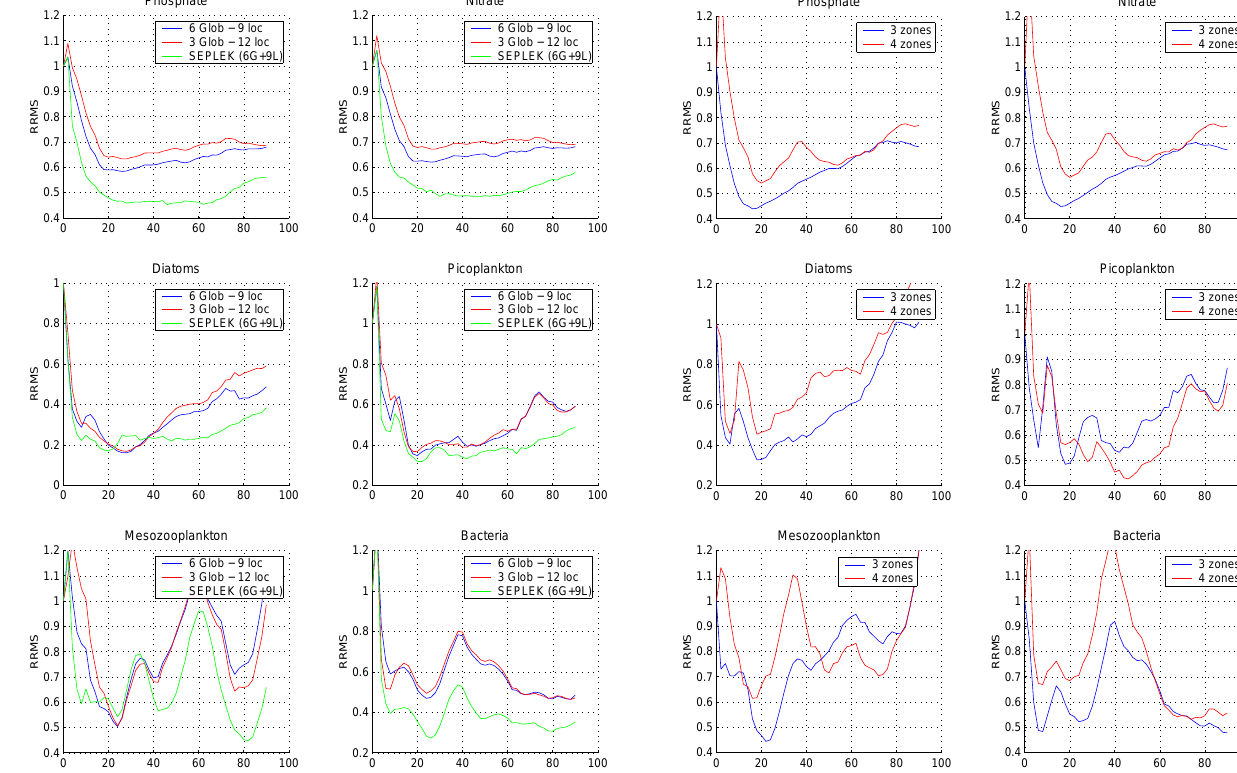
Fig. 7. Evolution in time of phosphate, nitrate, diatoms, picoplank- ton, mesozooplankton and bacteria RRMS from the SFPLEK filter assimilating profiles using global-local EOFs from 3 vertical sub- domains with 3 global − 17 local EOFs, 6 global − 14 local EOFs, and from the SEPLEK filter with 6 global - 14 local EOFs.